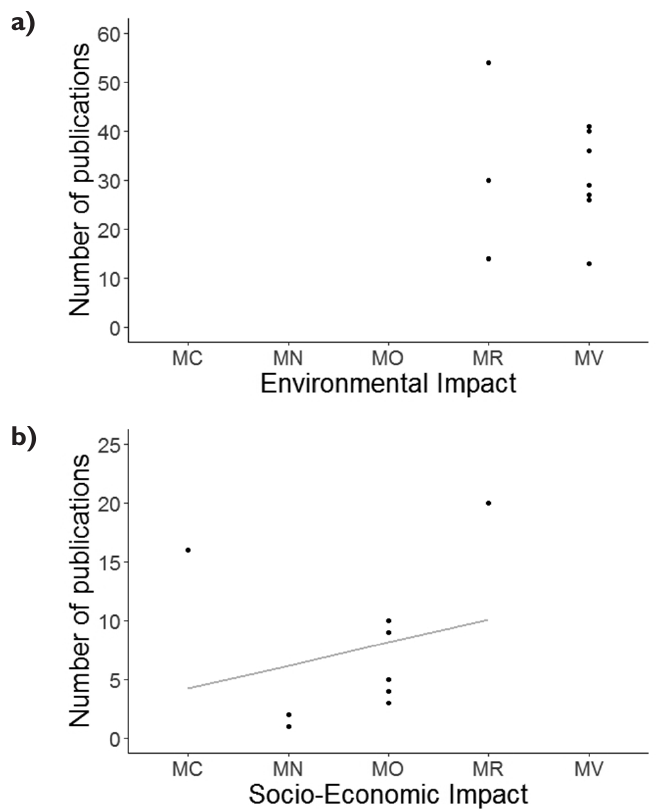
Figure 4. The relationship between the number of publications and a environmental impact scores us- ing EICAT scores and b socio-economic impact scores for alien mammals using SEICAT, where each dot represents a species and the line represents the relationship between impacts and number of publications. Maximum GISS scores and the sum of GISS environmental and socio-economic scores showed the same pattern as Figure 4a and b, respectively (results not